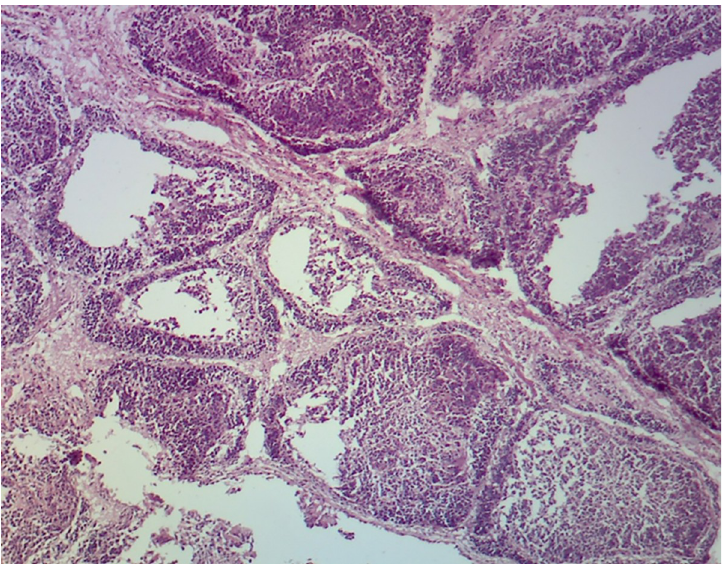
Fig 2. Histopathological section of BF of chicken with lymphocytic depletion with marked atrophy of lymphoid follicles and thickening of interfollicular space by severe fibrosis (40X magnification, H&E staining). https://doi.org/10.1371/journal.pone.0254605.g002 icosahedral shape of virus particles with pentameric protrusions on each fivefold vertex. The five to fivefold distance measures 750 angstroms, in which the VP2 protein of IBD virus appeared to be organized in 260 trimers in fivefold vertices, making the edges and the face of the icosahedron (Fig 3).